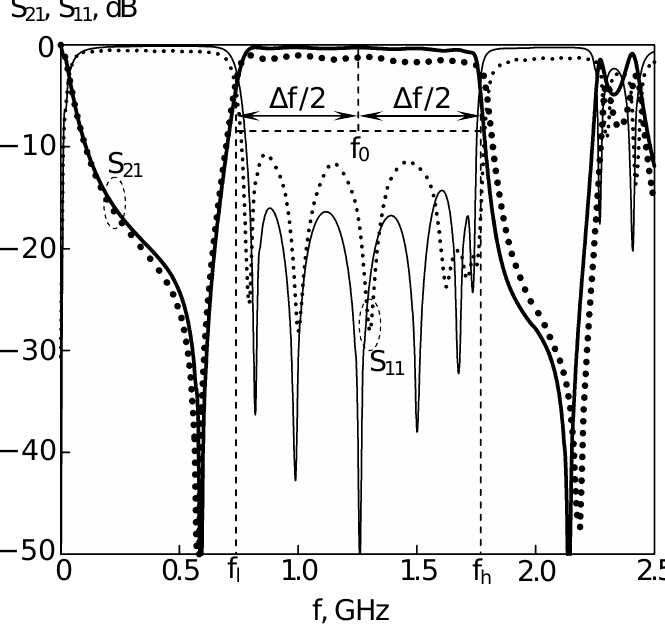
Figure 4. AFC of the U-shaped (twice slot-split rectangular) 6-mode resonator with an additional cut. Points – experimental data, lines – theoretical data (results of electrodynamic